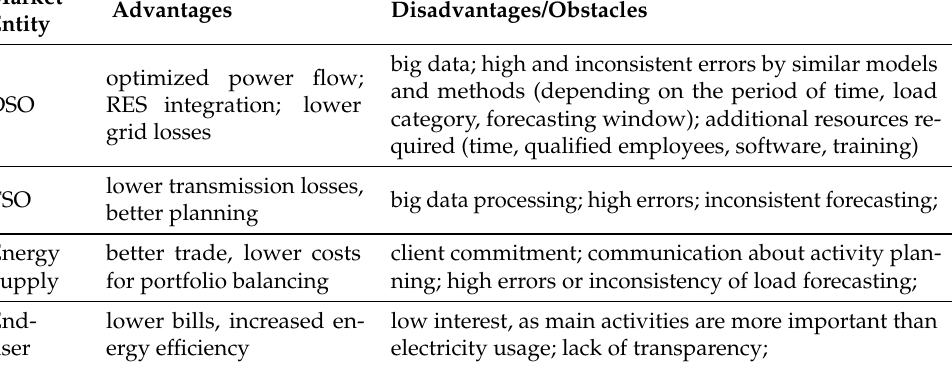
Table 1. Impact of load